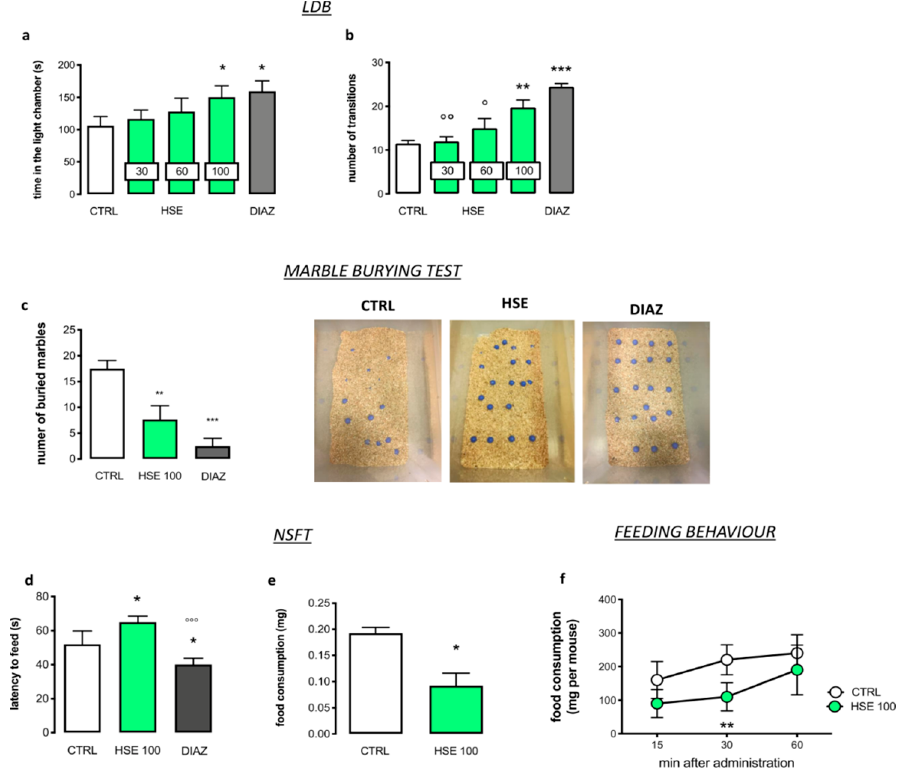
Figure 1. Anxiolytic-like activity of Helichrysum stoechas Moench methanolic extract (HSE). ( a , b ) In the light dark box (LDB) test, HSE 100 reduced the time spent in the light chamber ( a ; one-way ANOVA post-hoc Tukey, F(4,35) = 14.52, * p < 0.05 vs. CTRL) and an increase in the number of transitions ( b ; one-way ANOVA post-hoc Tukey, F(4,35) = 15.55, *** p < 0.001 ** p < 0.01 vs. CTRL; ◦◦ p < 0.01, ◦ p < 0.05 vs. DIAZ) compared to mice with anxiety-like symptoms (CTRL) and diazepam (DIAZ). ( c ) HSE 100 reduced the number of buried marbles compared to CTRL (one-way ANOVA post-hoc Tukey, F (2,21) = 116.4, *** p < 0.001 ** p < 0.01 vs. CTRL). ( d , e ) In the novelty suppressed feeding test (NFST) HSE 100 increased the latency to feed ( d ; one-way ANOVA post-hoc Tukey F(2,21) = 42.36, * p < 0.05 vs. CTRL, ◦◦◦ p < 0.001 vs. DIAZ) and reduced food consumption ( e ; Student’s t -test, * p < 0.05 vs. CTRL). ( f ) The food consumption was evaluated with the feeding behavior (two-way ANOVA post hoc Sidak, F(2,24) = 7.176, ** p < 0.01 vs. CTRL). The vertical bars represent ± SD of eight animals per group ( n = 8).